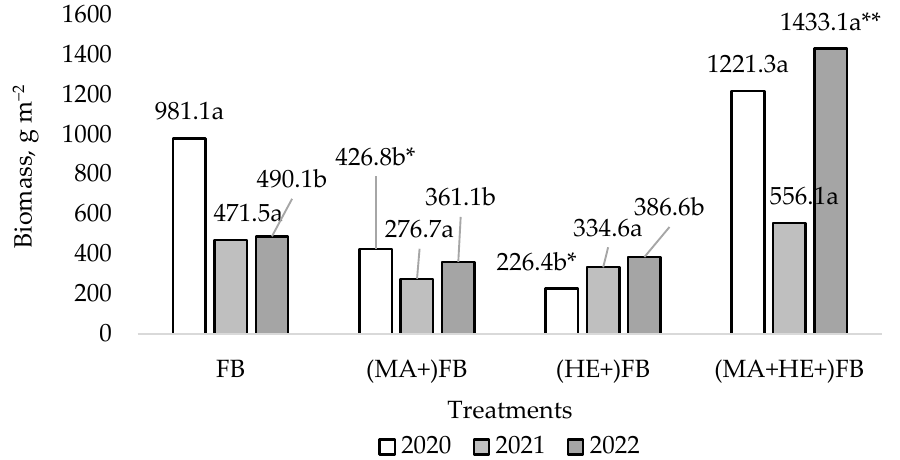
Figure 5. Impact of multi-cropping on faba bean dried biomass, 2020–2022. FB: faba bean single crop (control treatment), MA + FB: maize + faba bean, HE + FB: hemp + faba bean binary crops, MA + HE + FB: maize + hemp + faba bean ternary crop. Different letters (a, b, c) within columns of separate vegetative season show significant difference between treatments at p ≤ 0.05; * significant differences from FB at p ≤ 0.05; ** at p ≤ 0.01.